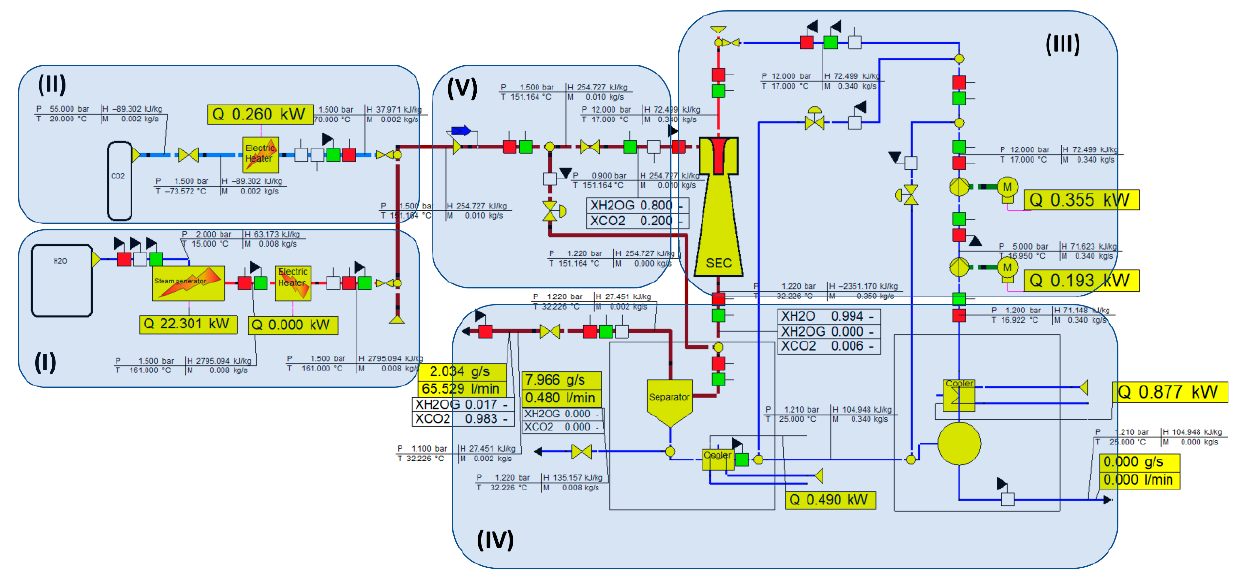
Figure 1. The concept of the designed test stand with the spray ejector condenser performances analysis opportunities. Superheated steam generation system ( I ), CO 2 supply and mixing system ( II ), spray-ejector condenser with the water supplying system ( III ), tank for water/steam/CO 2 mixture separation into gaseous and liquid parts with their common inlet and separate outlets ( IV ), connection system between the spray-ejector condenser and other parts ( V ).